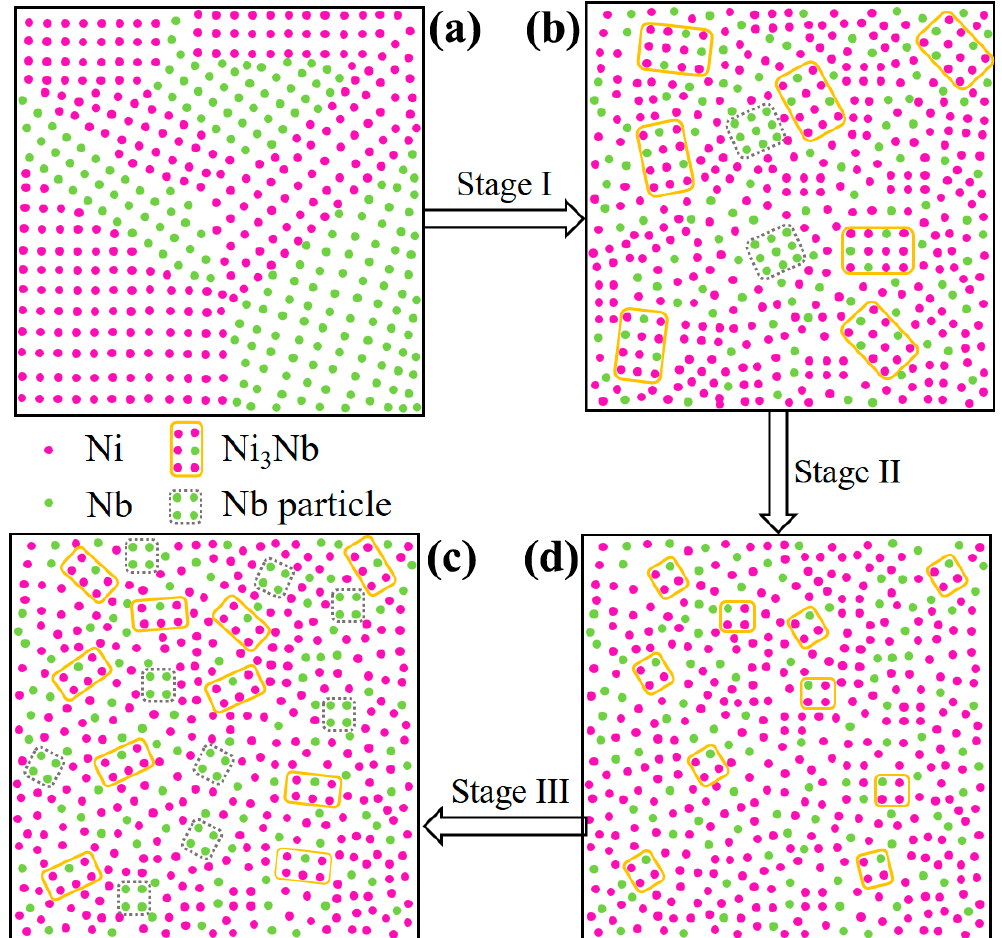
Figure 8. A schematic microstructure evolution for HCPEB irradiation. ( a ) Initial stage; ( b ) Partial amorphous; ( c ) Fully amorphous; ( d ) Nano-crystallization.